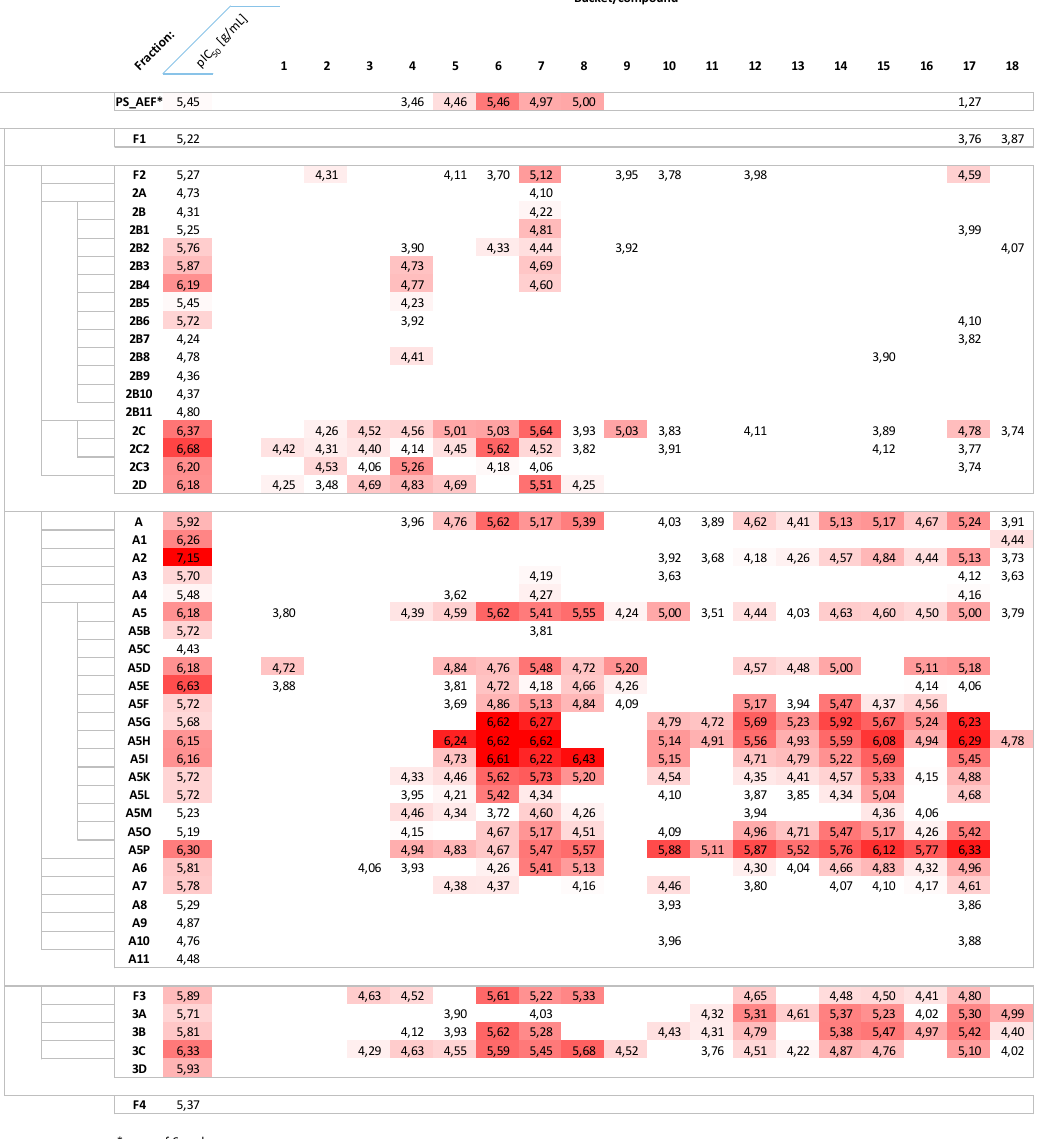
Figure 7. Heat map representation of the distribution and amount (log values of bucket intensity values) of the 18 selected compounds in the various fractions in relation to their anti-Tbr activity ( − log IC 50 (g/mL) = pIC 50 ), with a more intense red indicating higher activity and higher intensity. Fractions are ordered according to their occurrence in the fractionation scheme (compare Figure 8, Material and Methods section).